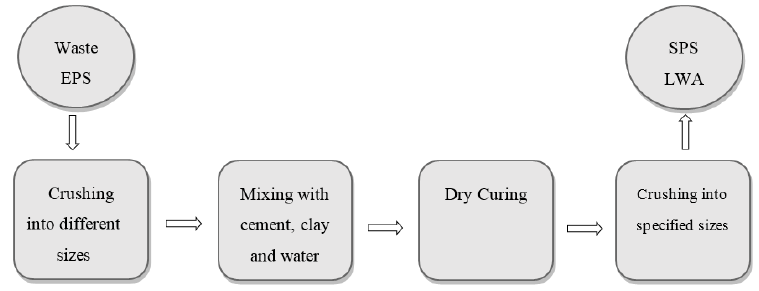
Figure 4. Production process of SPS aggregate.